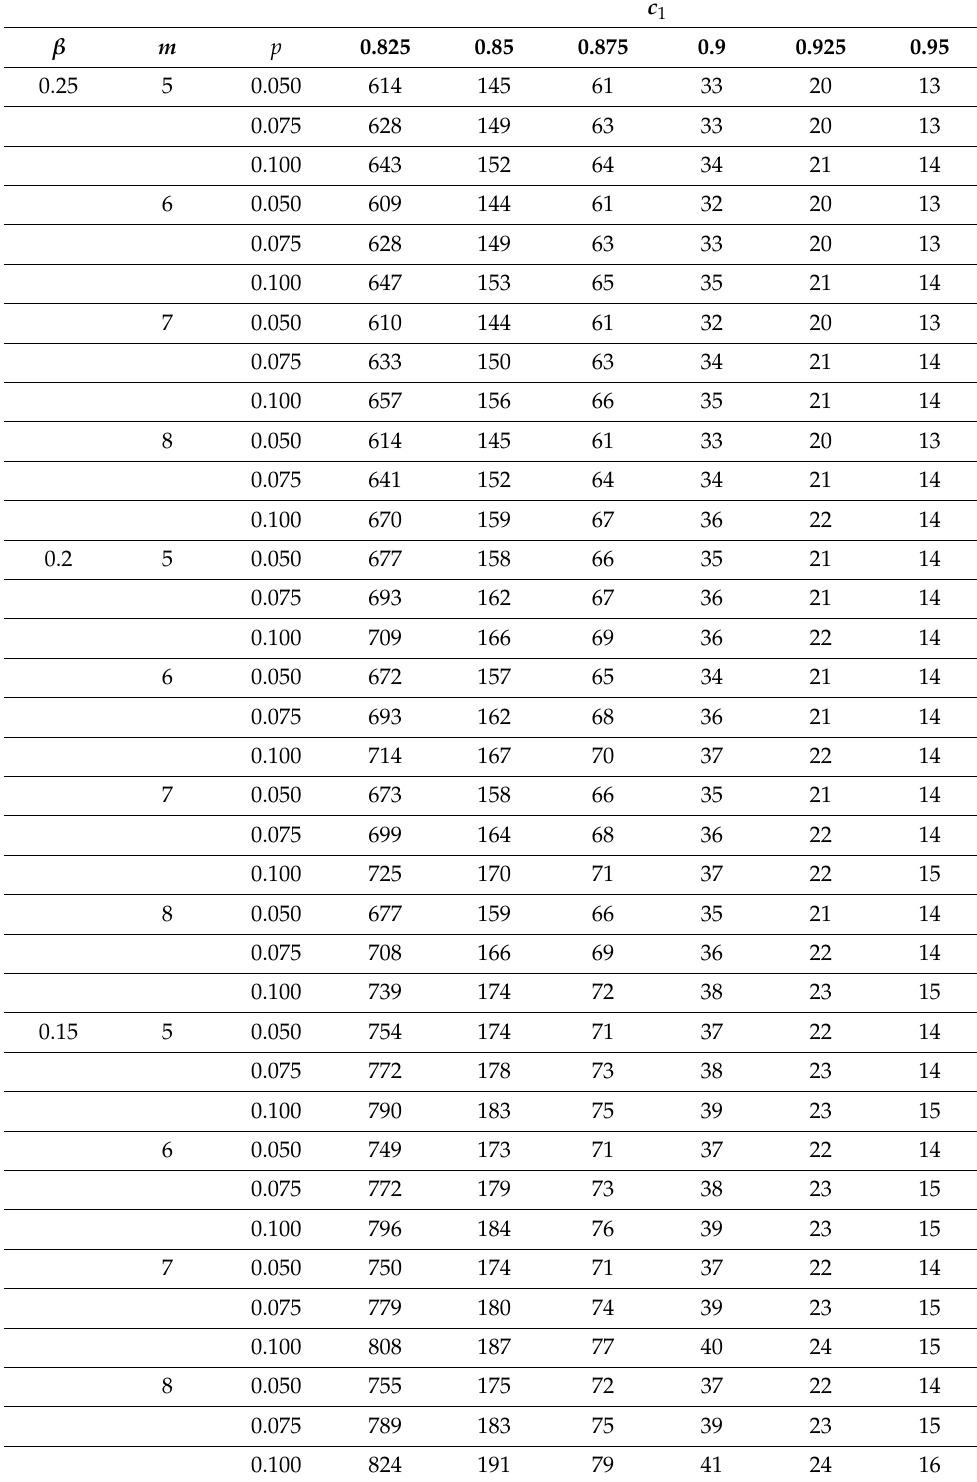
Table 1. The minimum sample size for c 1 = 0.825(0.025)0.9, m = 5(1)8 and p = 0.05(0.025)0.1 under α = 0.01, L = 0.05, T = 0.5, and c 0 =